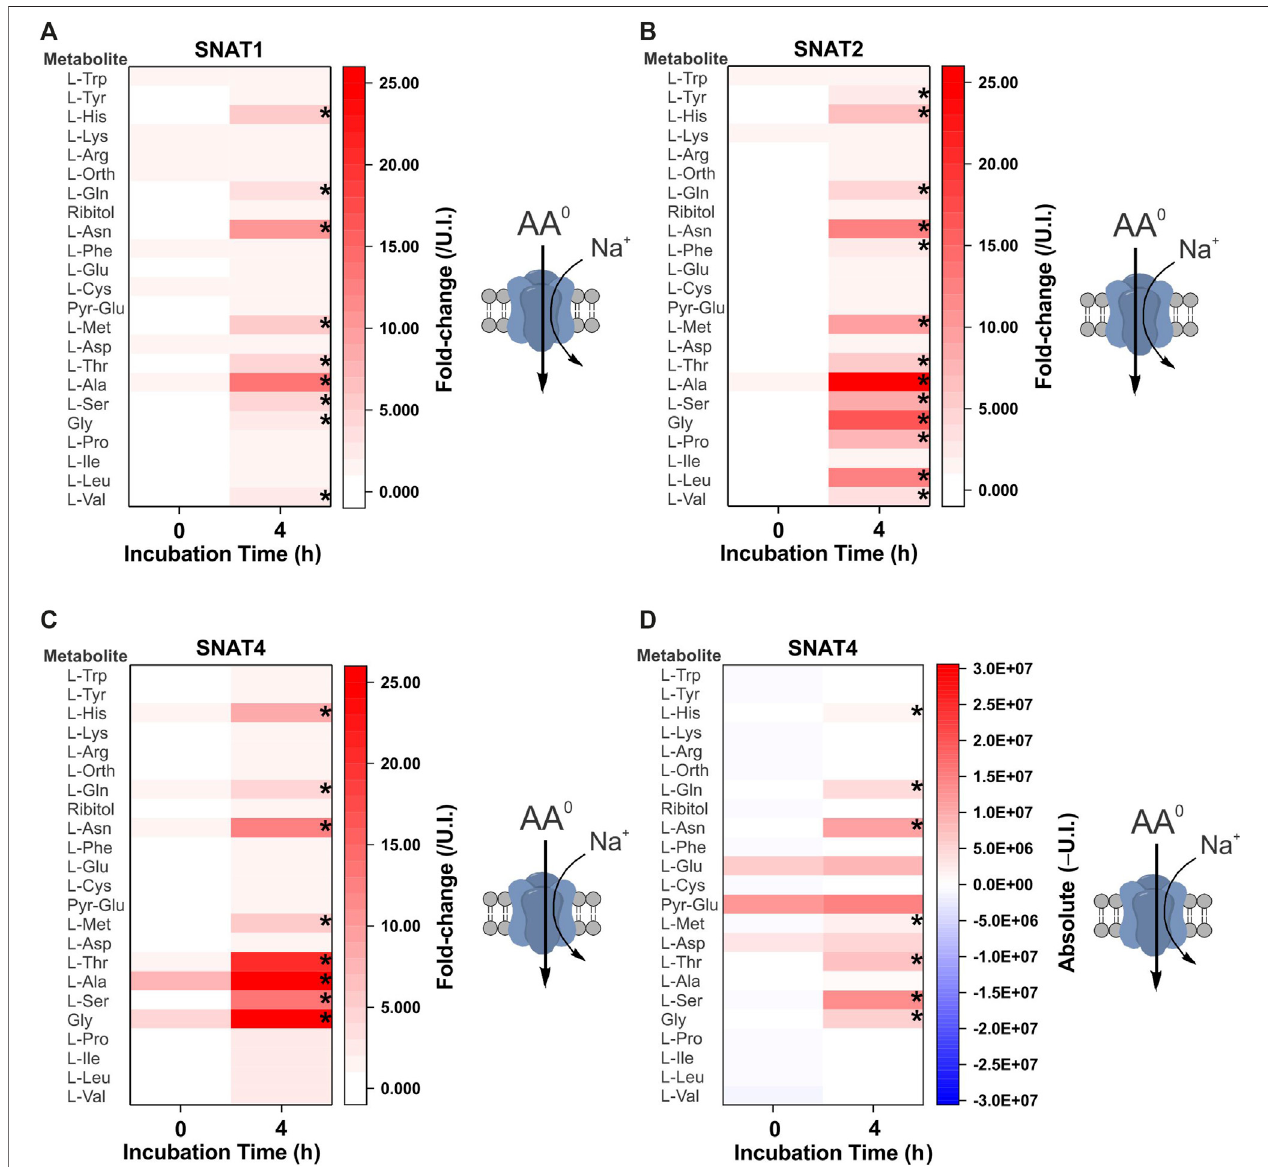
FIGURE2| Comprehensiveaminoacid fl uxpro fi leofhumanSNATvariants.Oocyteswereinjectedwith10 ngofcRNAofSNAT1/2/4transportersorremainedun- injected (controls). After4 days ofincubation inOR 2+ (pH7.8), oocytes wereincubated for 4 hinmodi fi edL-15 medium before metabolite extraction and analysis. Heat- maps show fold-change (A – C) or absolute peak difference (D) relative to un-injected oocytes. The published speci fi city and stoichiometry of transporters is shown as a cartoontotherightofeachheatmap.Thefold-change (A – C) ateachtimepoint(0and4 h)wascalculatedbydividingtheabsolutesignalforeachaminoacidbythe corresponding signal from un-injected oocytes, thereby taking account of any natural fl uctuations due to endogenous acquisition pathways during incubation. The absolute value heat-map (D) was generated by subtracting the signal of un-injected oocytes from the signal of transporter expressing oocytes at each time point (0 or 4 h).A more intense red for the same amino acidat 4 hindicates active accumulation. Pyro-glutamic acid(2-oxo-proline) and ornithinewere included inall heatmaps as they are known GC-MS derivatives of glutamate and arginine, respectively. The internal standard ribitol was also included in each heat map as a negative control to indicate any deviation from fold-change of 1 ± 0.1. * Indicates a difference in the means between the two time points at the p < 0.05 level using a paired t -test as calculated from the absolute mass spectrometer raw values. The fi gures are a representative example of 3 experiments with n (cid:2) 12 transporter-expressing and un- injected oocytes per